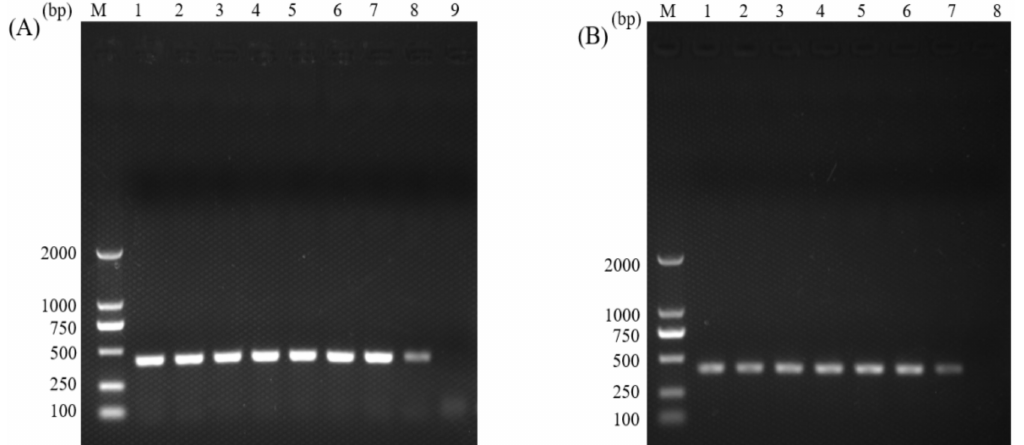
Figure 2. Optimization of the annealing temperature ( A ) and the primer amounts ( B ) of the nano-PCR assay. ( A ) lane M: DL2000 DNA Marker (TakaRa); lane 1: 50 ◦ C; lane 2: 50.5 ◦ C; lane 3: 52 ◦ C; lane 4: 54 ◦ C; lane 5: 56 ◦ C; lane 6: 58 ◦ C; lane 7: 59.5 ◦ C; lane 8: 60 ◦ C; lane 9: negative control. ( B ) lane M: DL2000 DNA Marker (TakaRa); lane 1: 2 pmol; lane 2: 4 pmol; lane 3: 6 pmol; lane 4: 8 pmol; lane 5: 10 pmol; lane 6: 12 pmol; lane 7: 14 pmol; lane 8: negative